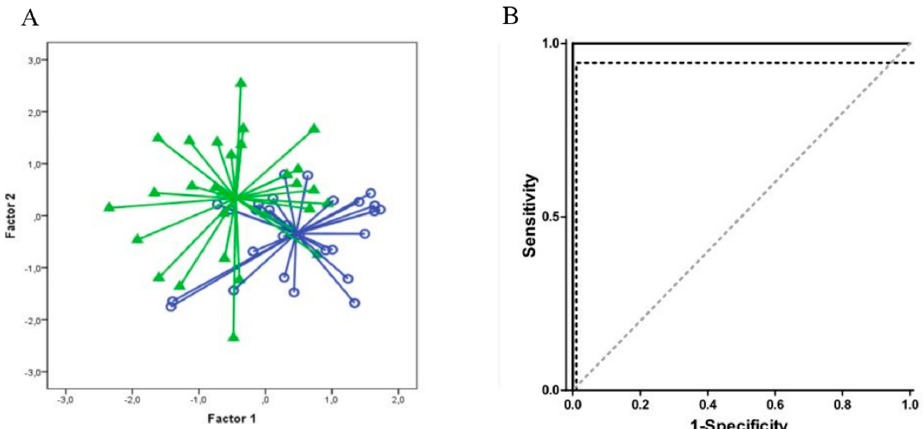
Figure 22. ( A ) Scatterplot for the discrimination of patients with ulcerative colitis at presentation (full triangles) and healthy controls (empty circles), by electronic nose. Axes depict two orthogonal linear recombinations of the original 32 sensor data by means of principal component analysis; ( B ) Receiver operator characteristic curve for the discrimination of ulcerative colitis and healthy controls at first presentation (solid line) and upon achieving remission (dashed line), by electronic nose. The areas under the curve ± 95% confidence interval (AUC ± 95% CI) with associated p -value were: first presentation 1.00 ± 0.00, <0.001; remission 0.94 ± 0.05, <0.001. Used with permission from